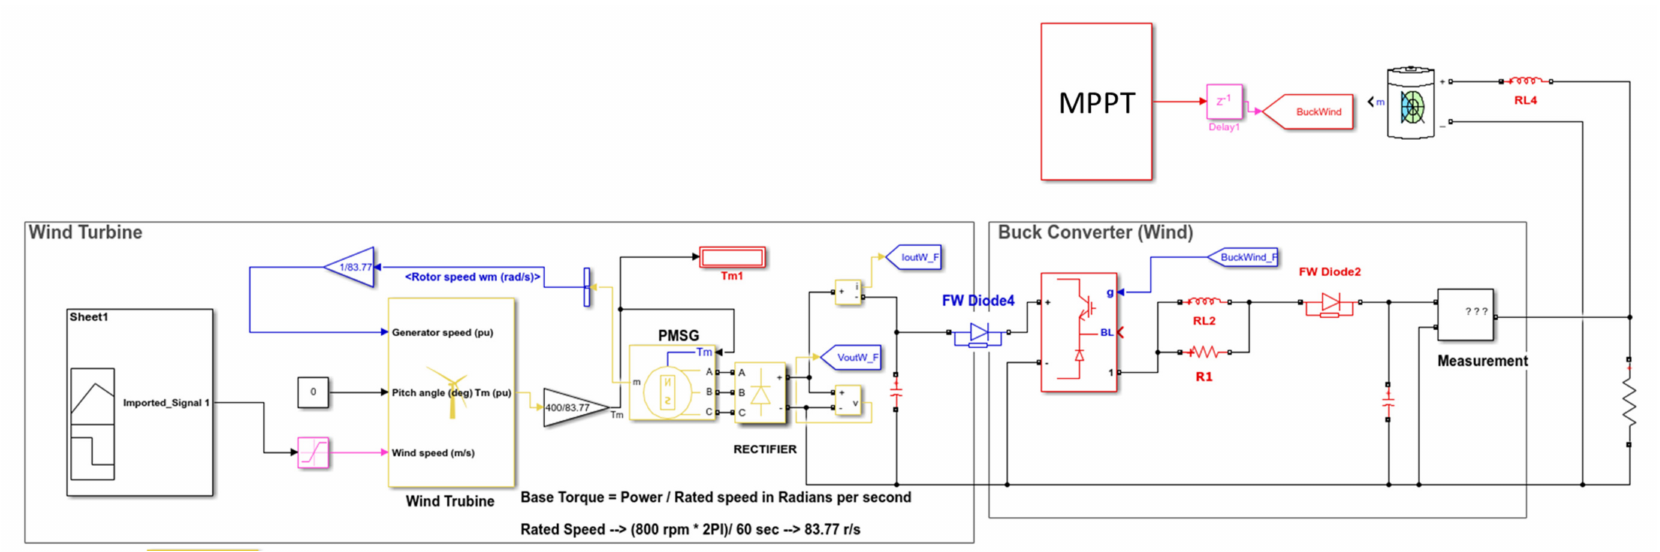
Figure 12. Wind generator Simulink